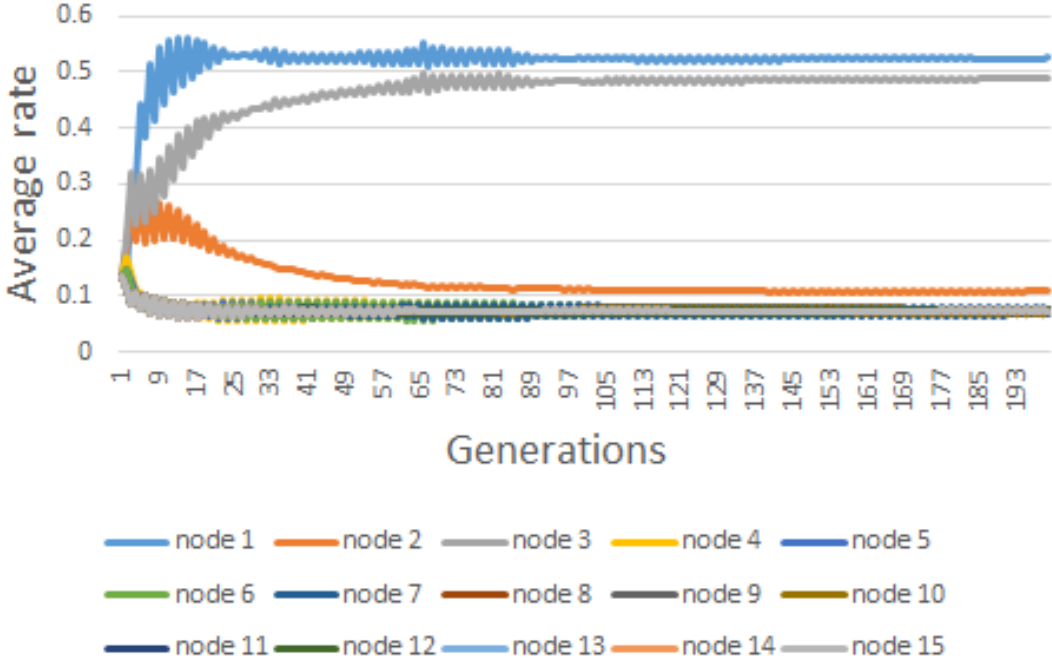
Figure 7. Evolution graphs for average defense rate for the nodes of the case study. The defender’s budget equals to 2.0. The x-axis presents the generations. The y-axis presents the evolution of average